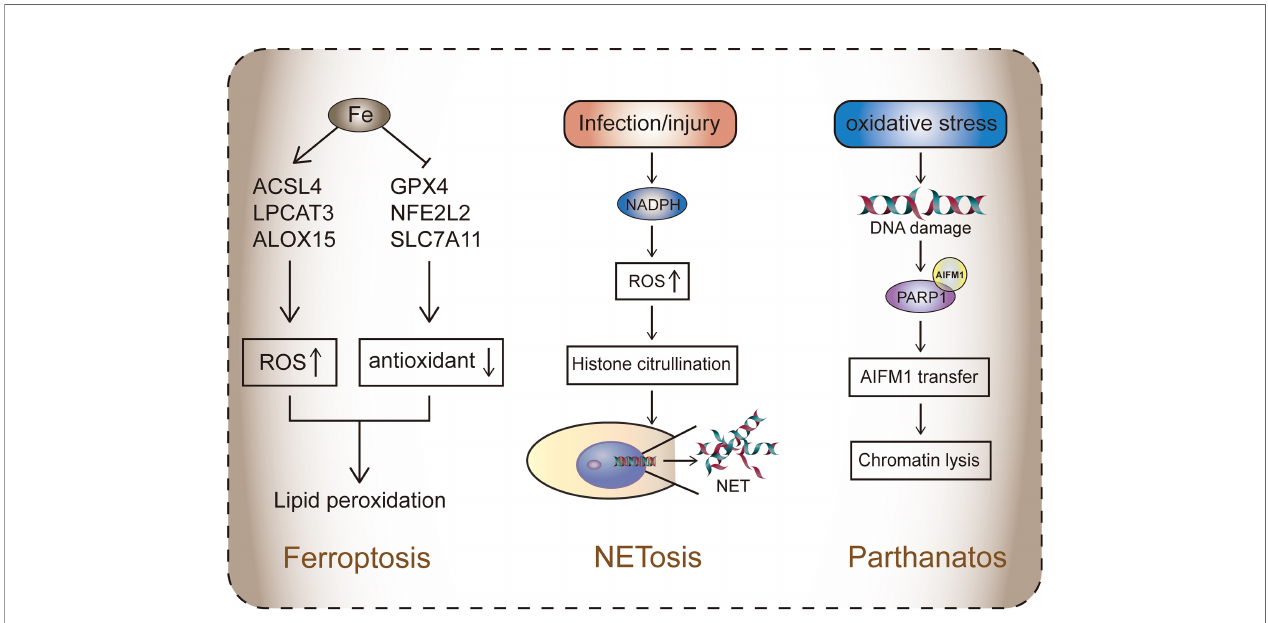
FIGURE 2 | The three RCDs that do not rely on caspase. Ferroptosis is caused by the accumulation of iron, which is activated by the disruption of the balance between ROS and the antioxidant system. ACSL4, LPCAT3, ALOX15, and other genes mediate fatty acid oxidation, resulting in lipid toxicity in cells. Antioxidant systems such as Xc-, GPX4, and NFE2L2 protect cells from ROS. Ferroptosis is mainly dependent on the formation of PUFA-OOH. In system Xc-, GPX4 participates in the reduction of lipid peroxides (such as PUFA-OOH) and inhibits ferroptosis. In the lipid metabolism pathway, lipid droplets decompose to PUFA and AA/AdA. The latter is processed by ACSL4-LPCAT3-ALOX15 to form PUFA-OOH.NETosis: ROS mediated by NADPH activates histone citrullination, leading to the release of NET (chromatin in the nucleus), which blocks invading substances such as pathogens.Parthanatos: Oxidative stress leads to DNA damage. Activated PARP1 binds to AIFM1, causing the latter to migrate to the nucleus, leading to the dissolution of part of the